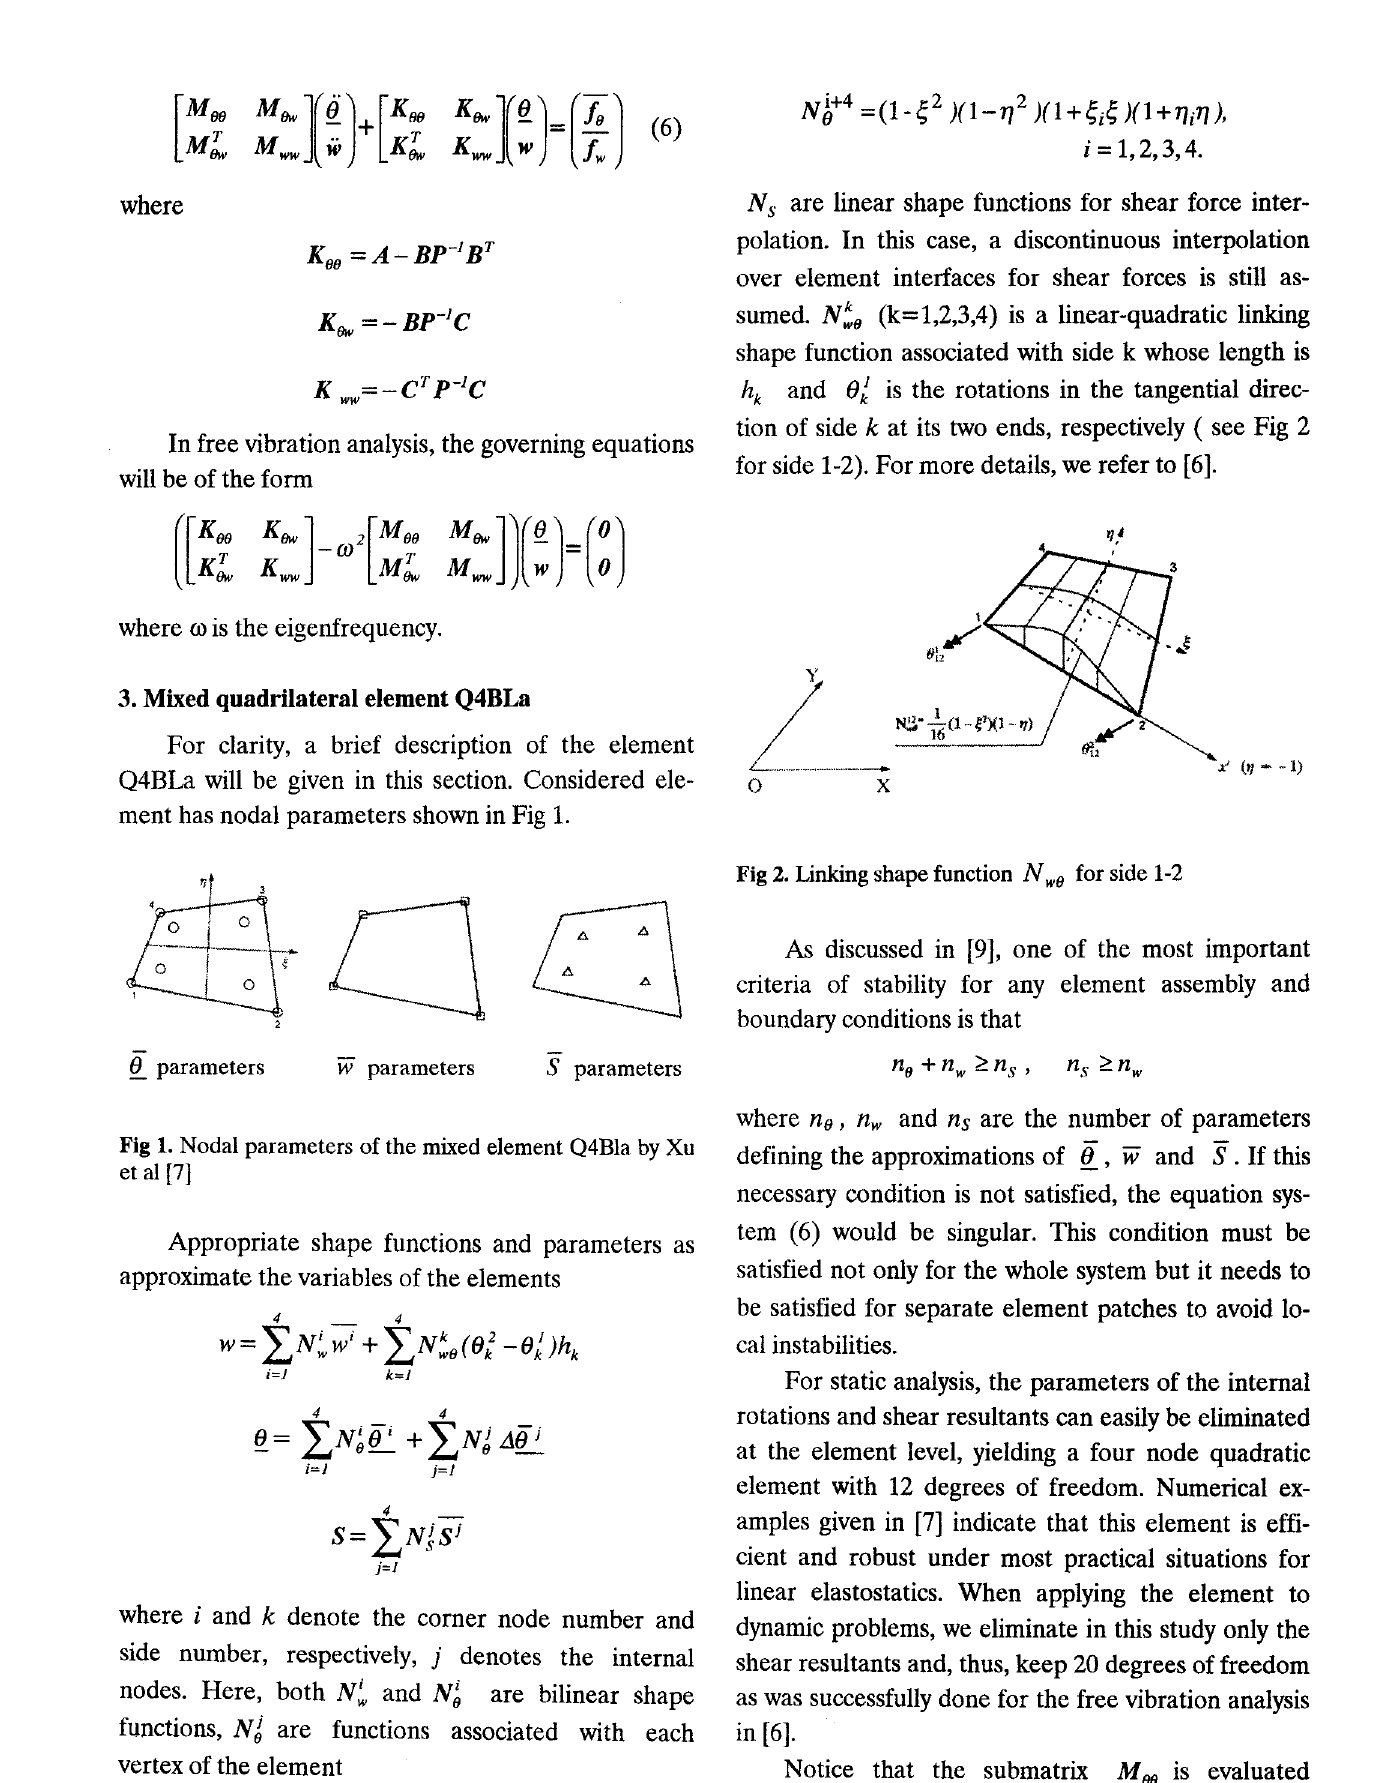
Fig 2. Linking shape function N wo for side